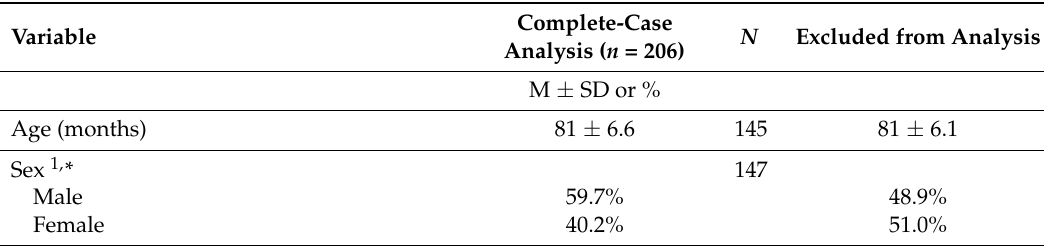
Table 1. Sample characteristics and comparison between children included and excluded from analysis due to missing